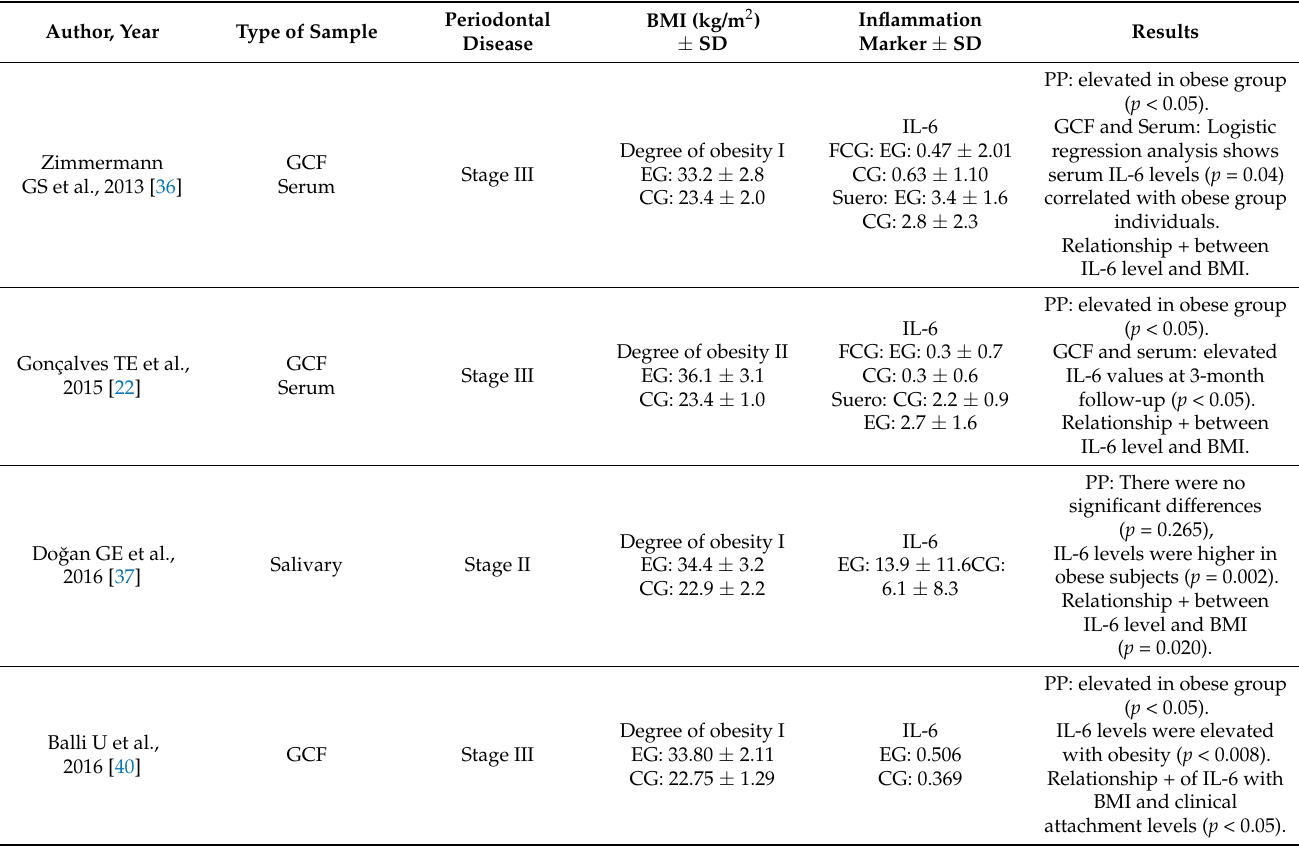
Table 5. Studies Carried out With Different Markers of Inflammation using the ELISA